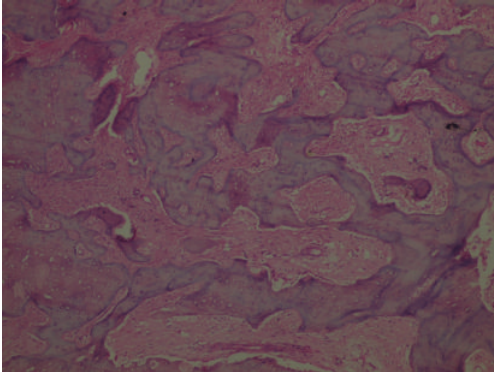
Figure 4: A photomicrograph showing “C” or “Chinese letter” shaped bony trabeculae in a highly cellular connective tissue (H/E, 10X).